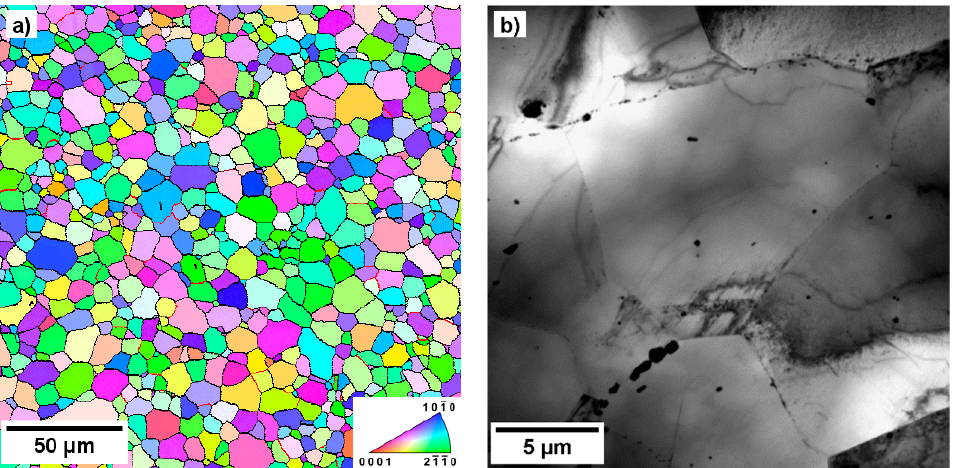
Figure 2. ( a ) Electron backscattered diffraction (EBSD) orientation map and ( b ) transmission electron